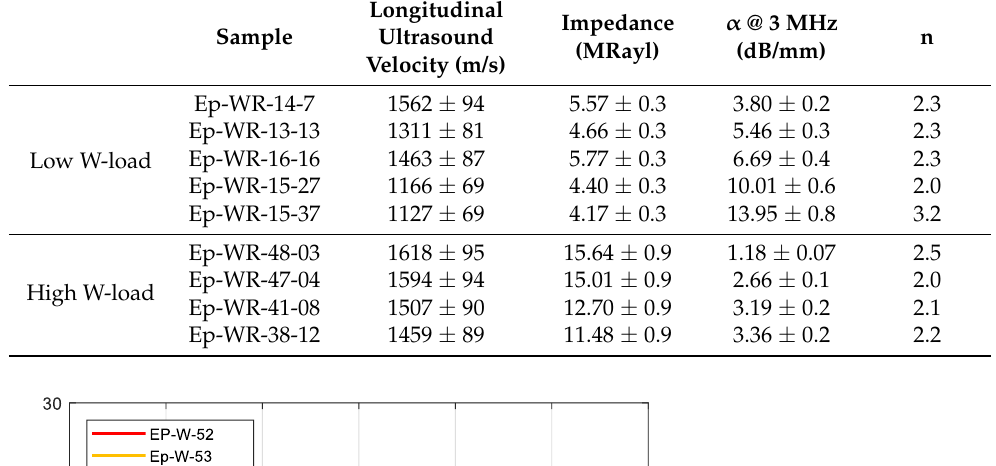
Table 10. Measured ultrasonic properties of the tungsten + rubber-loaded epoxy composites.